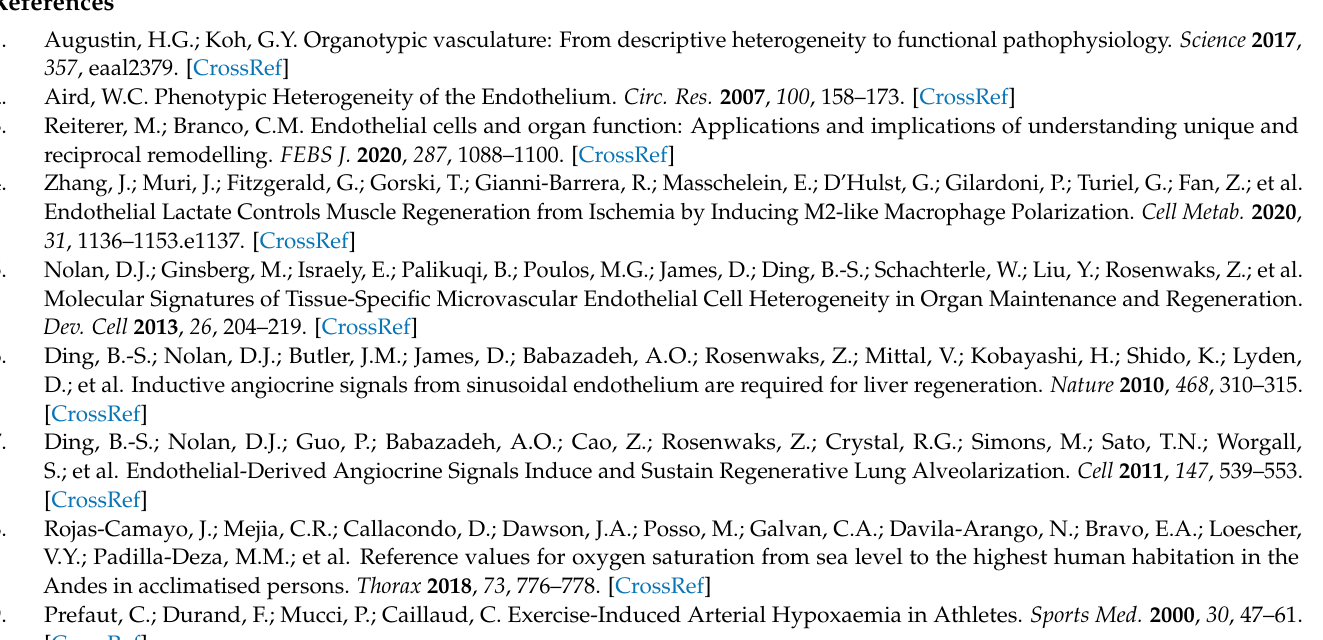
Figure S4: Upstream regulation of HIF- α is mildly affected by O 2 but is not tissue-specific (Related to Figure 2); Figure S5: Oxygen levels affect glucose uptake, cell proliferation and migration; Figure